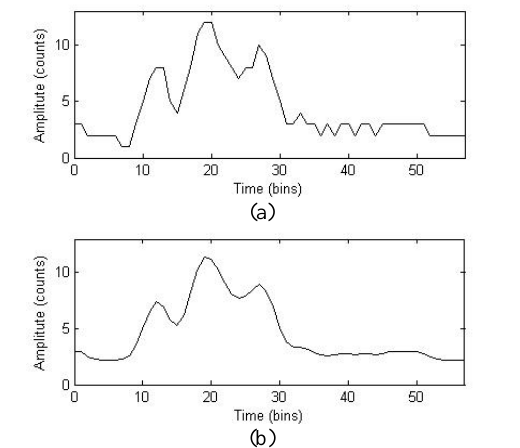
Figure 2. (a)Example of the RIEGL raw backscattered signal. (b) Pre-processed result of the RIEGL raw signal